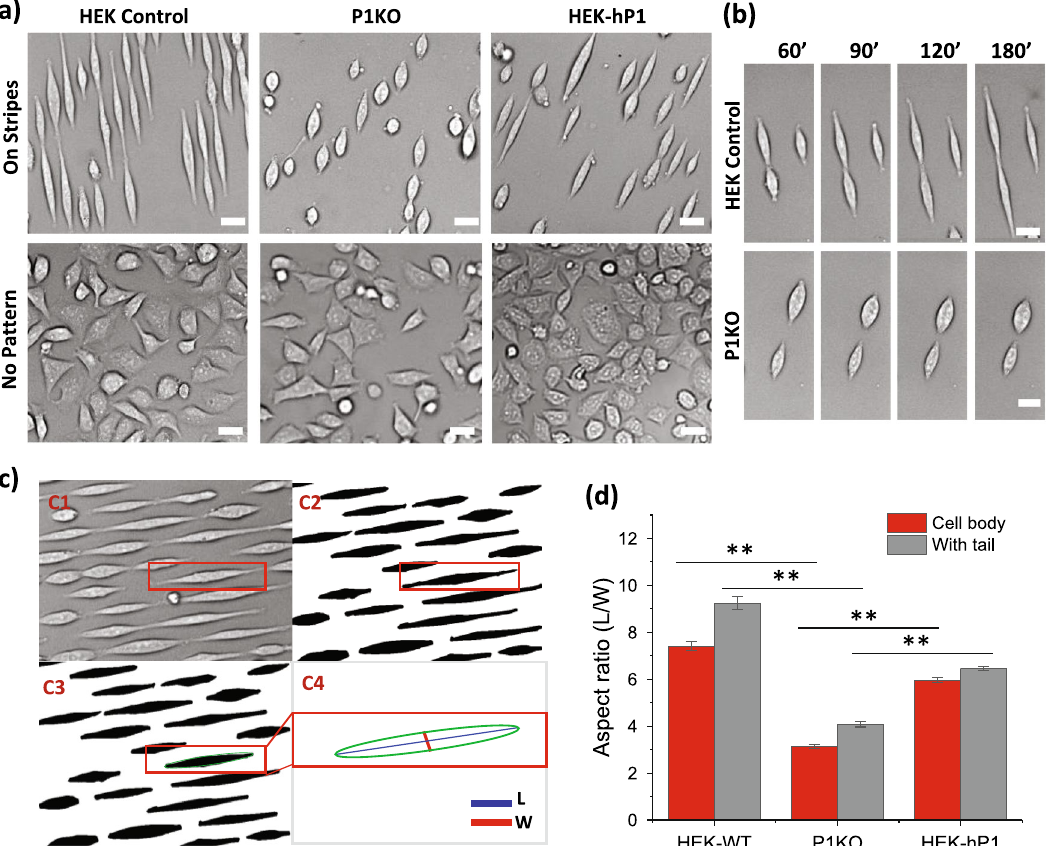
Figure 1. Role of Piezo1 on cell response to micropatterns. (a) Images of control, Piezo1 knockout (P1KO), and human Piezo1 expressing (hP1) HEK293T cells following fibronectin microstrips (upper panel), and controls for each cell types without patterning (lower panel). It shows that Piezo1 is required for cells’ response to micropatterns. All images were taken 2.5 h after cell seeding. ( b) Time sequence of cell expansion on stripes of control (upper panel) and P1KO cells (lower panel), showing P1KO cells lost the ability to elongate on the stripes. (c) Image processing steps. (c1,c2) show brightfield images were transformed to a binary image in MATLAB and cells were identified using “adaptive threshold”. (c3) After an erosion and a dilation operation, the cell bodies were restored while the tail-like features were removed. (c4) Individual cells were fitted with ellipses and the ratio of major and minor axes of the ellipses was defined as the aspect ratio. (d) Statistical analysis of the aspect ratio of cell body (red) and cell body with tails (gray) for each cell type (n = 120 from more than 6 experiments for each cell type, * *p < 0.001). Scale bars represent 20